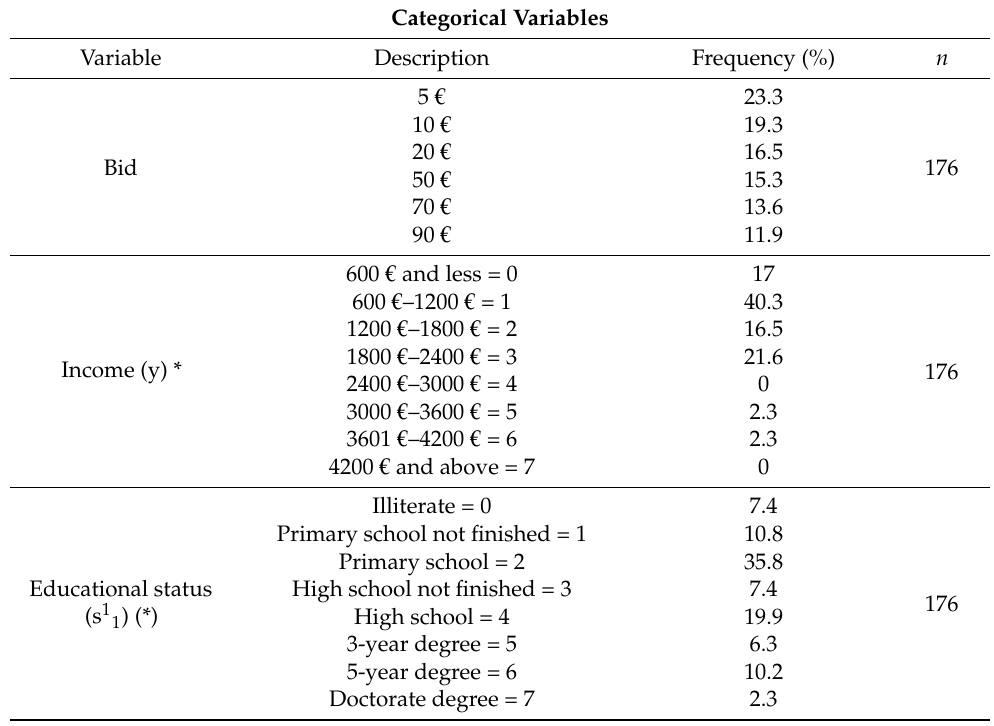
Table 1. Summary statistics for WEMHP (Wild Edible Mushroom Harvesting Permit) model